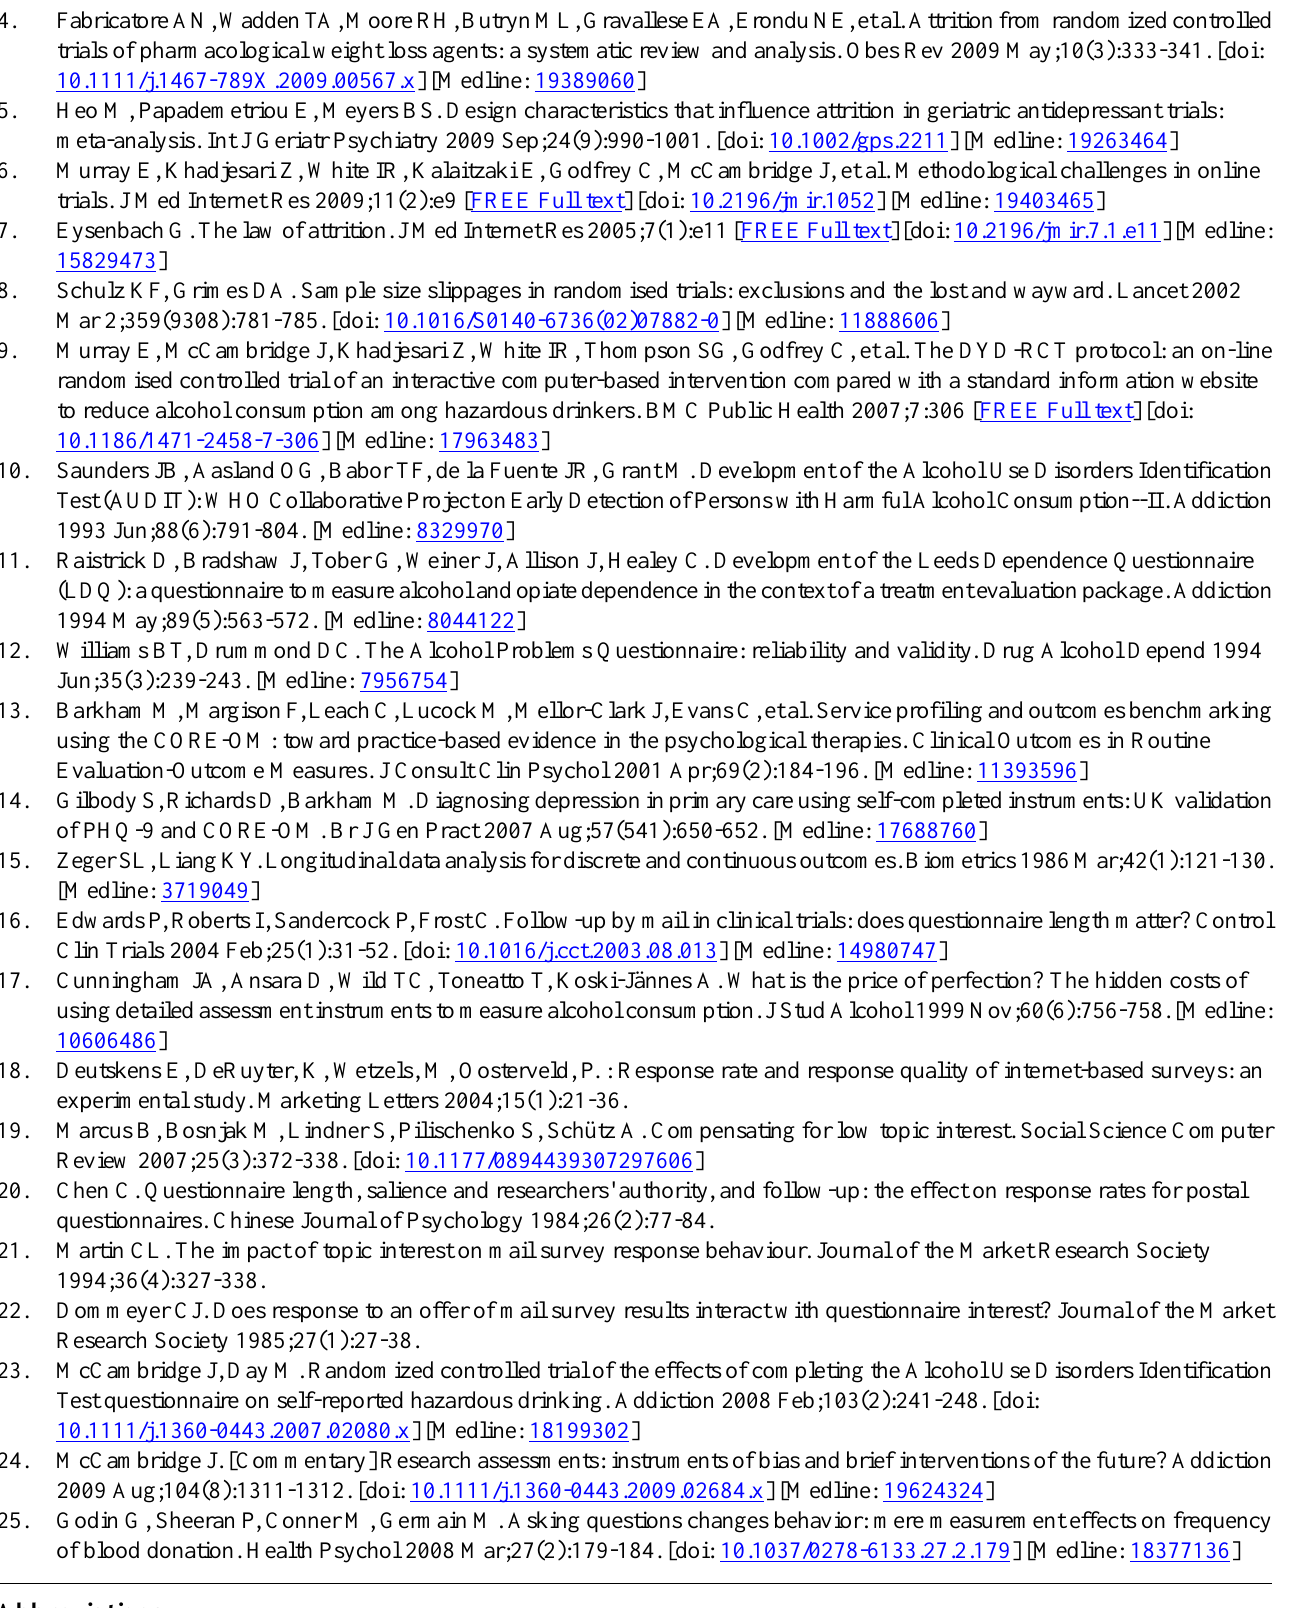
CORE-OM: Clinical Outcomes in Routine Evaluation-Outcome